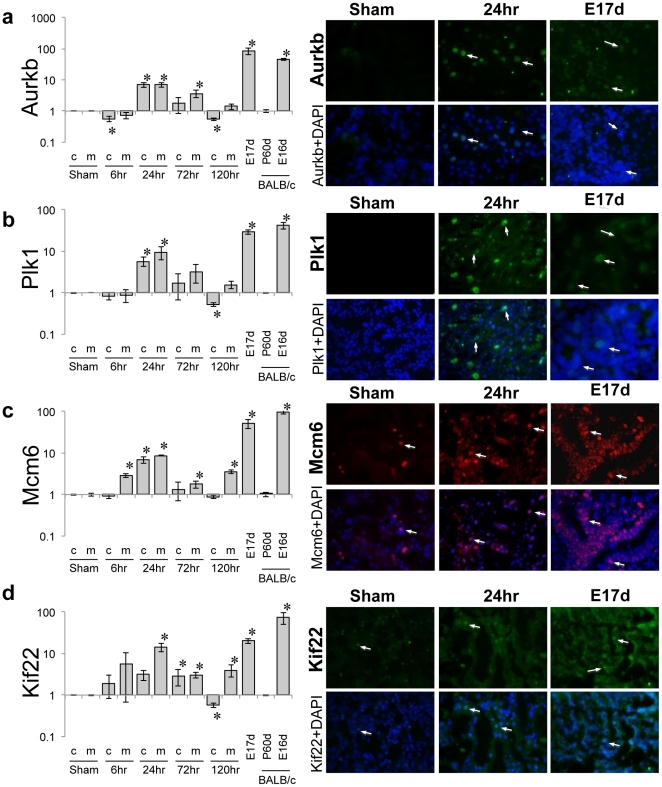
Quantitative mRNA levels.
A. mRNA levels of Aurkb were measured by real-time quantitative PCR in rat and mouse kidney (left). Rat kidneys collected at 0 hr (shame), 6 hr, 24 hr, 72 hr, and 120 hr after ischemic injury are shown for cortex (c) and medulla (m), respectively. The expression levels are shown for embryonic rat kidney (embryonic day 17; E17d) along with those of mouse kidney (E16d and P60d as embryonic day 16 and postnatal day 60, respectively). All data were normalized using GAPDH as a control gene. Immune fluorescence analysis shows the absence of Aurkb expression in sham rat kidney; however, embryonic kidneys and those after 24 hr of ischemic injury show increased Aurkb expression, the nuclear co-localization of which were confirmed by DAPI staining (right). B, C, D are similarly shown for Plk1, Mcm6 and Kif22. 40× magnification.